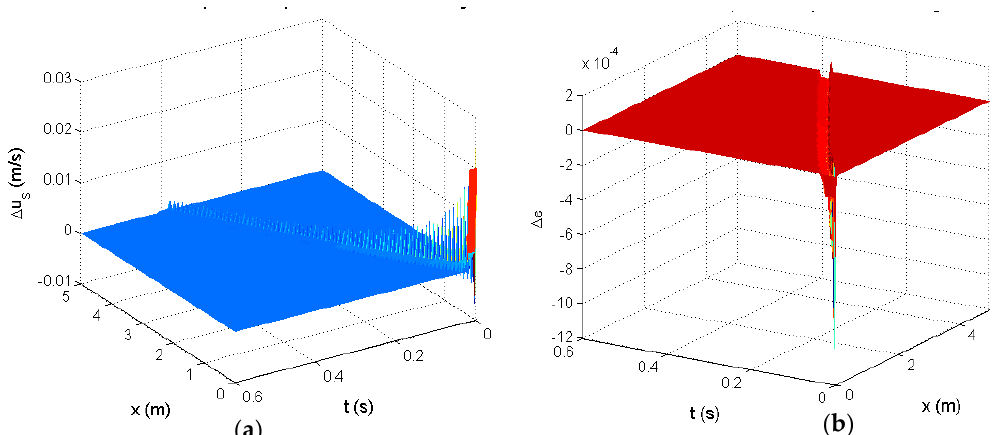
Figure 14. Simulated impulse response of the 2-PDE riser model: ( a ) – the solid velocity response, ( b ) – the voidage response.